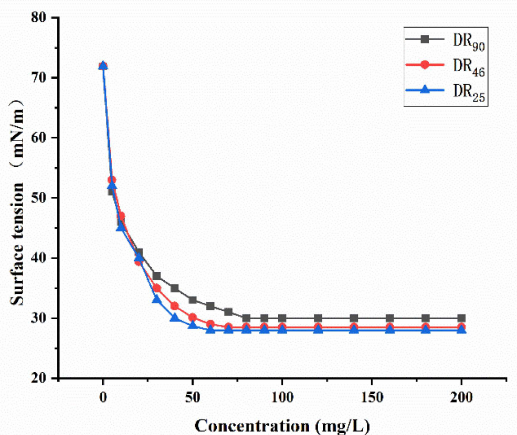
Figure 2. The CMC determination for